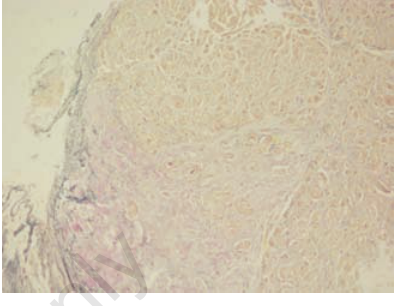
Figure 2. Microphotograph showing increased elastin in the endocardium also seen extending into the myocardium. Elastic stain X 280.